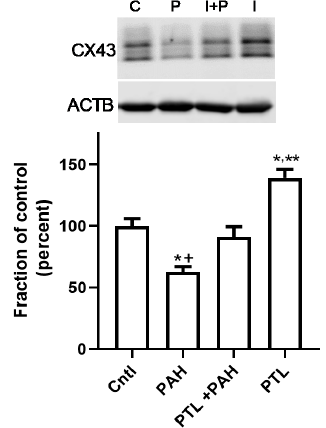
Figure 5. CX43 protein is not suppressed by LMW PAH exposure in the C10 cells in the presence